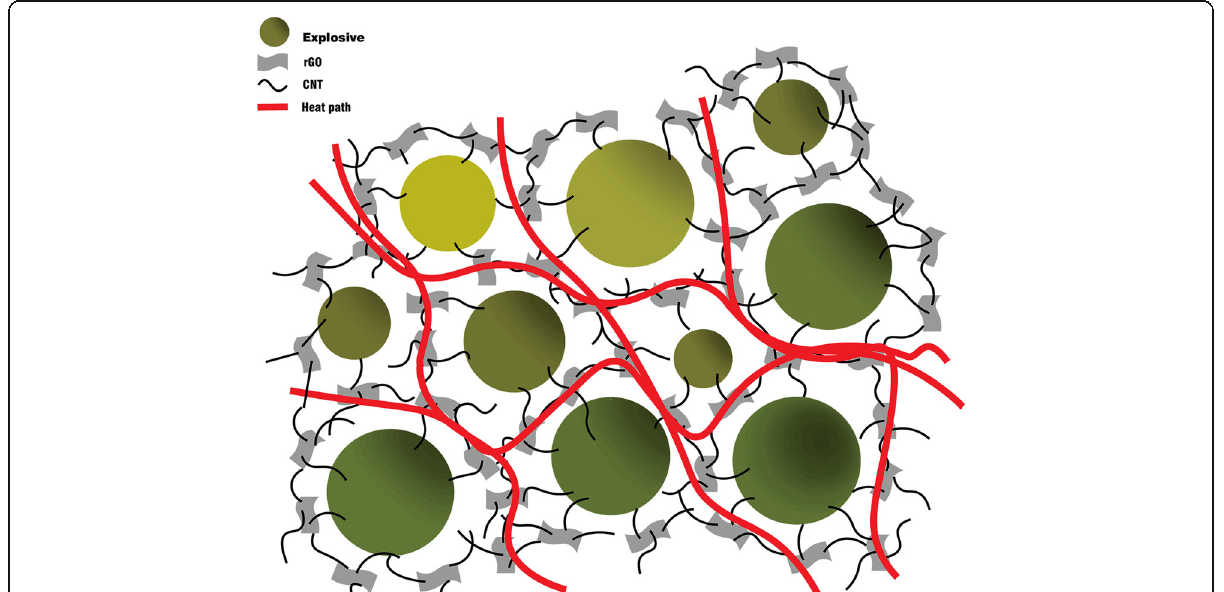
Fig. 7 Schematic diagram of thermal transfer of CL-20/rGO+